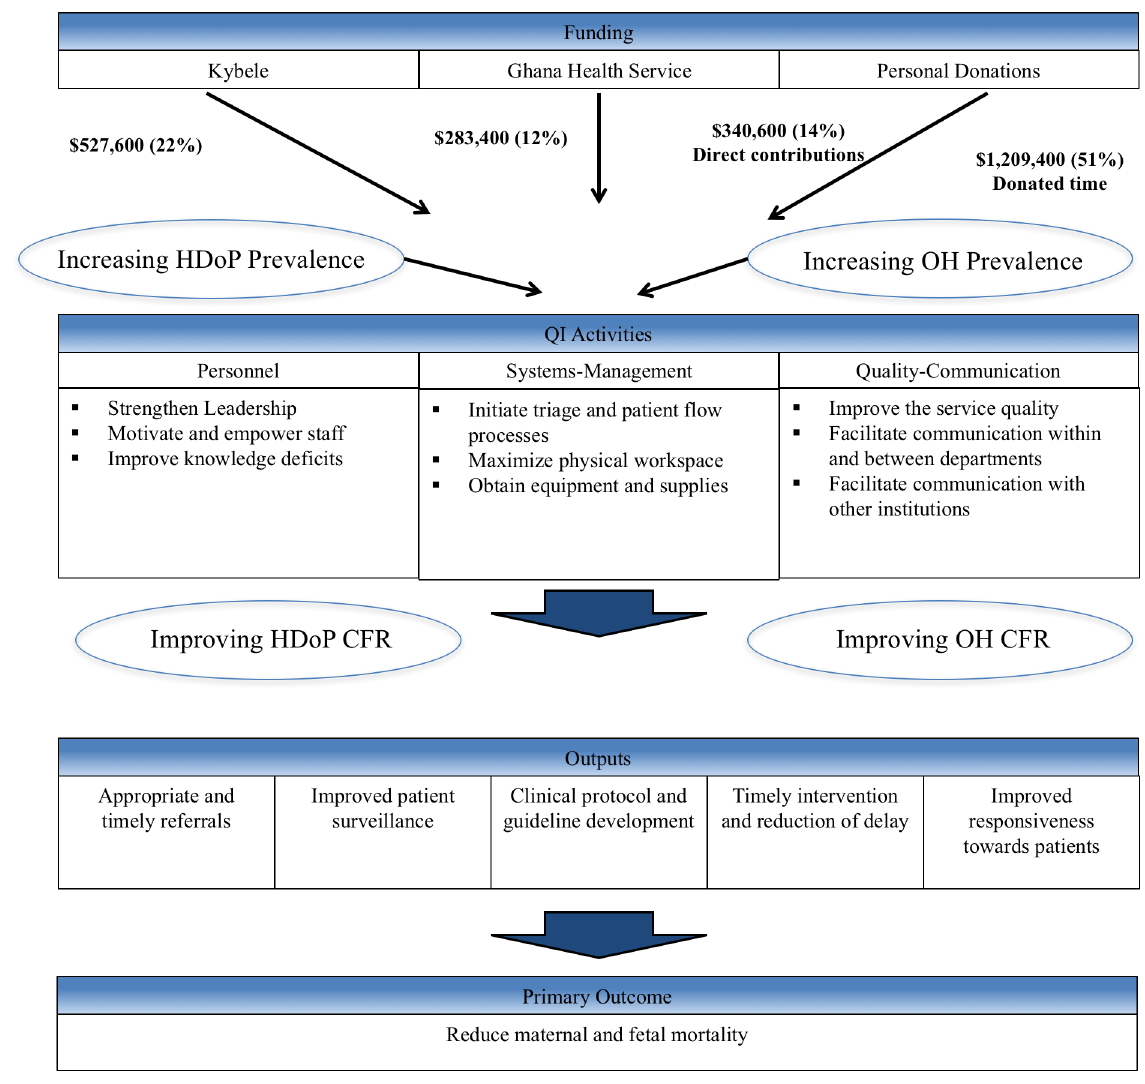
Fig 1. Analytical model for Kybele-GHS institutional framework of change model. GHS, Ghana Health Service; HDoP, hypertensive disorders of pregnancy; OH, obstetric hemorrhage; CFR, case fatality rate; QI, qualityimprovement; Dollarvalues in $2015